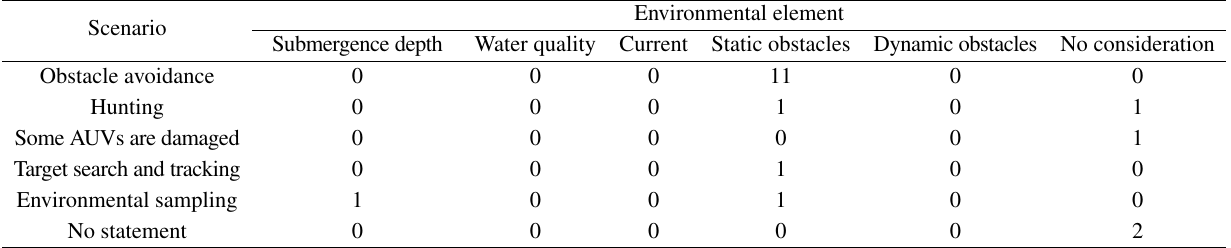
Table 5 Distribution of papers that consider different environmental factors and scenarios.